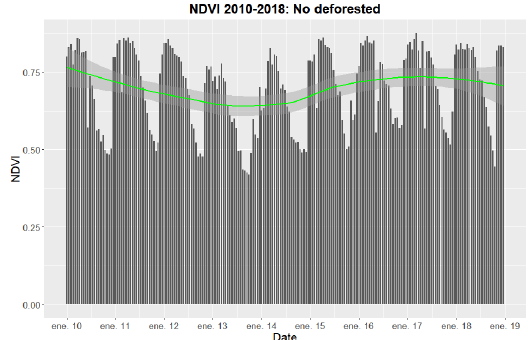
Figure 6. NDVI time serie of the no-deforested area. The green line shows the result of the LOESS local